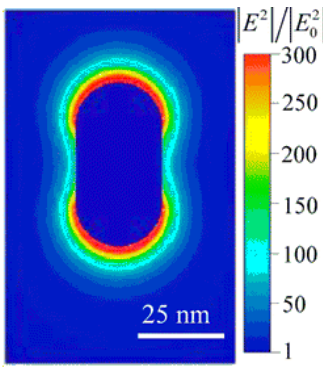
Figure 7. Finite element simulation of the intensity enhancement due to localized surface plasmon resonance of a gold nanorod. E 0 represents the field from the incident light and E represents the local field in the vicinity of the nanorod. Reprinted by permission from Macmillan Publishers Ltd.: Nature Nanotechnology [94]), copyright (2012).